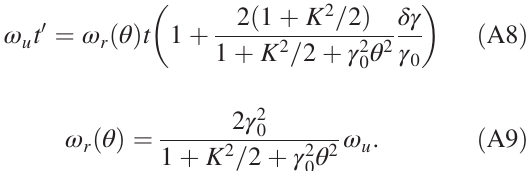
FIG. 10. The universal function X ð h Þ describing how the individual pulse energy varies with harmonic number h